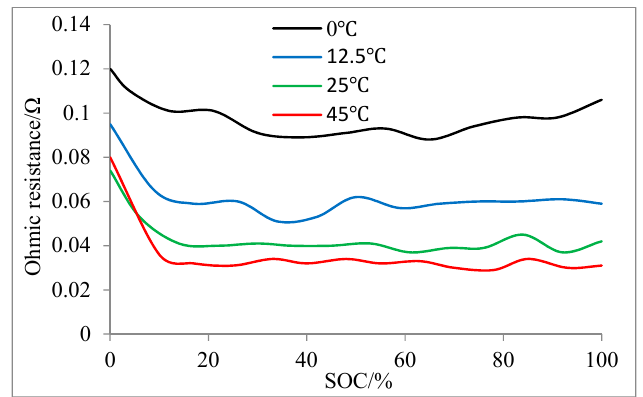
Figure 7. Ohmic resistance at different temperatures, state of charge (SOCs).